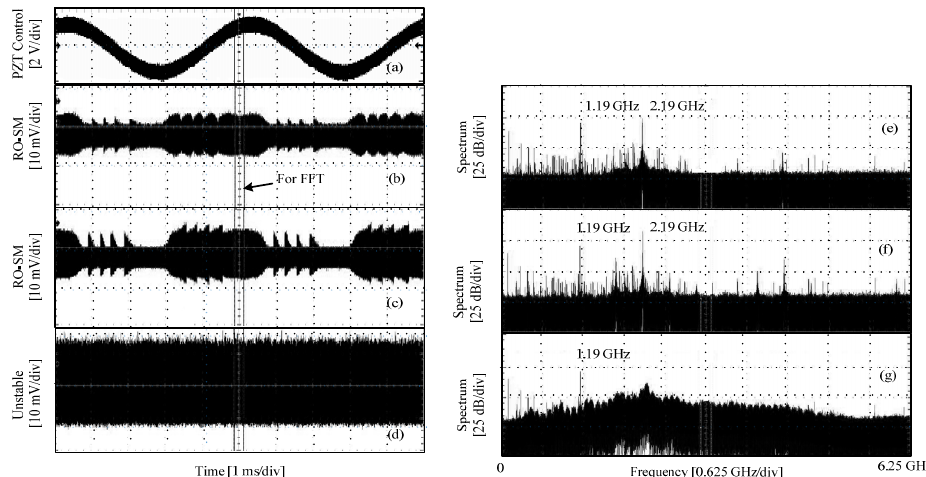
Figure 4. Experimental signals and their spectra in semi-stable and unstable regions. ( a ) PZT control signal; ( b , c ) RO-SM signals in semi-stable region; ( d ) SM signal in unstable region; ( e – g ) Spectra corresponding to ( b – d ) respectively.